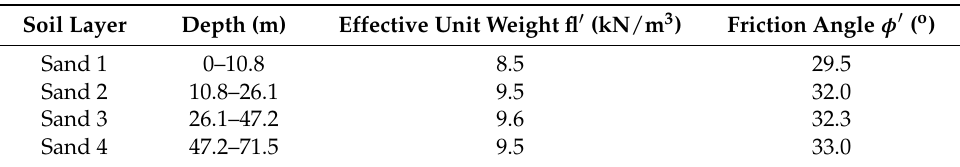
Table 1. BH-01 simplified soil layers.